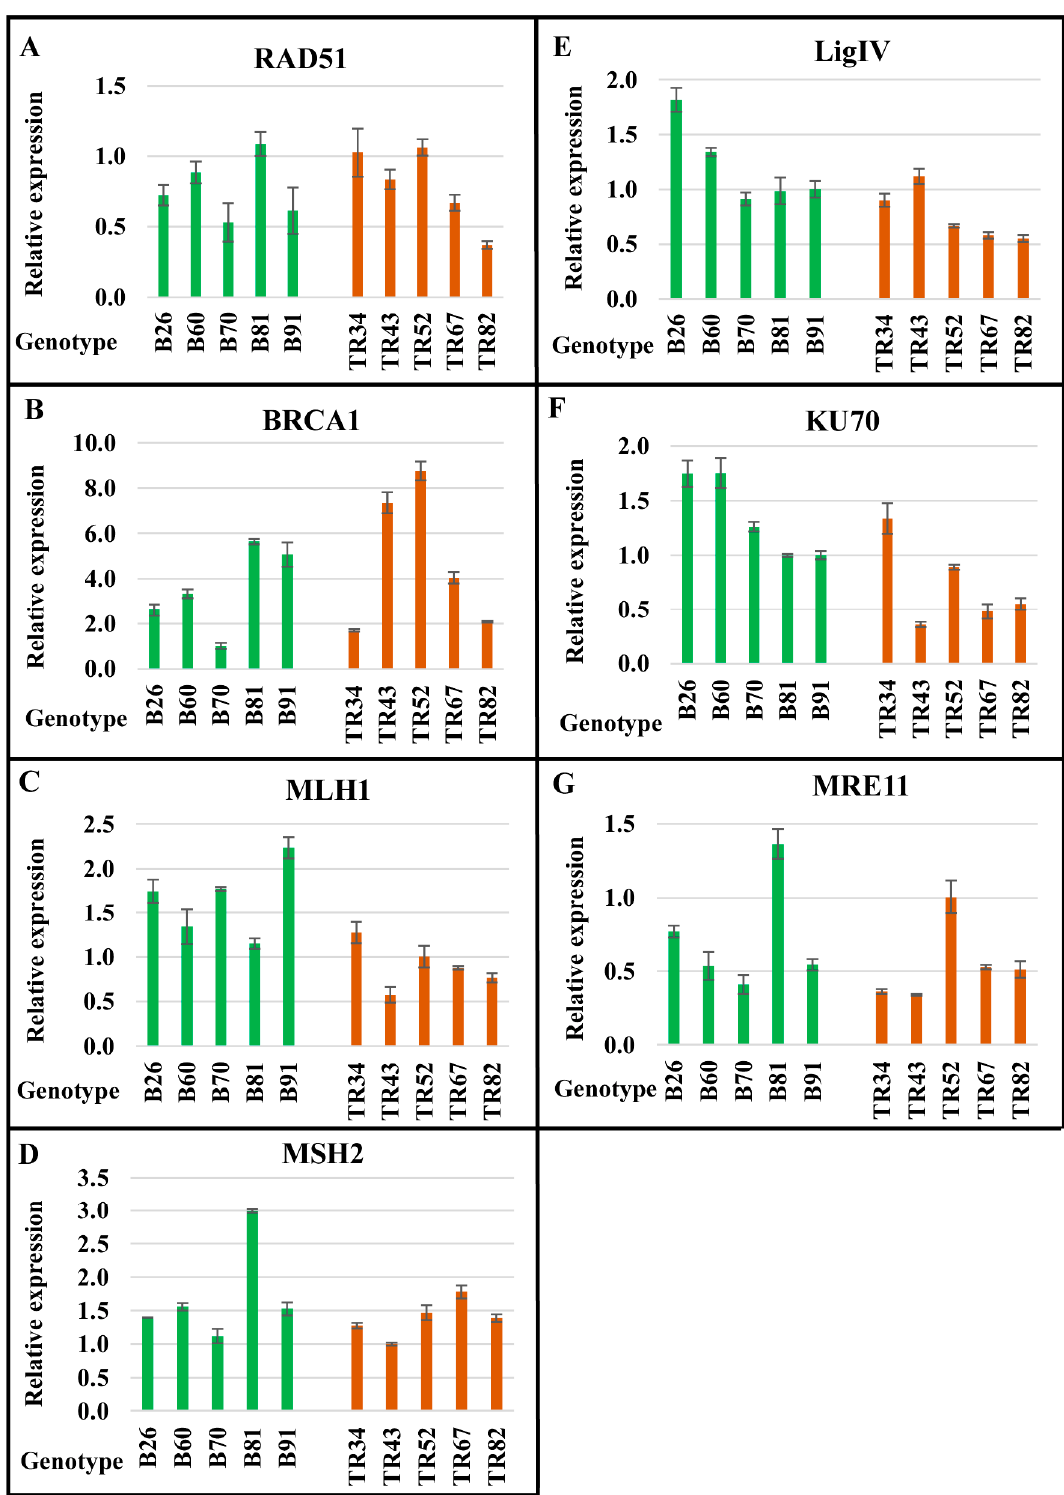
Figure 1. Real-time qPCR expression analysis of the genes involved in DNA repair pathways in individual plants from the Basalt (B) and the Terra Rossa (TR) microsites of the Tabigha population. The relative expression values of RAD51 ( A ), BRCA1 ( B ), MLH1 ( C ), MSH2 ( D ), LigIV ( E ), KU70 ( F ), and MRE11 ( G ) are represented. Standard deviation bars are shown.